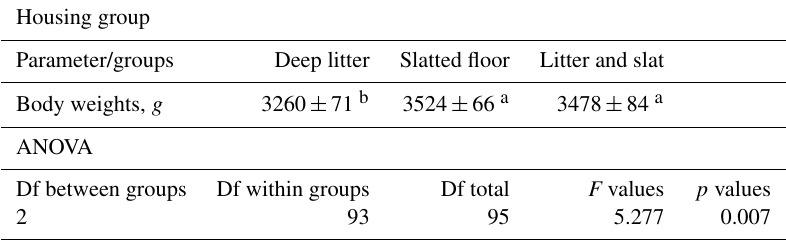
Table 1. The mean values and standard error of the mean (SEM) of the live body weight of broilers in the different groups ( g ). Df is degrees of freedom. Housing group Deep